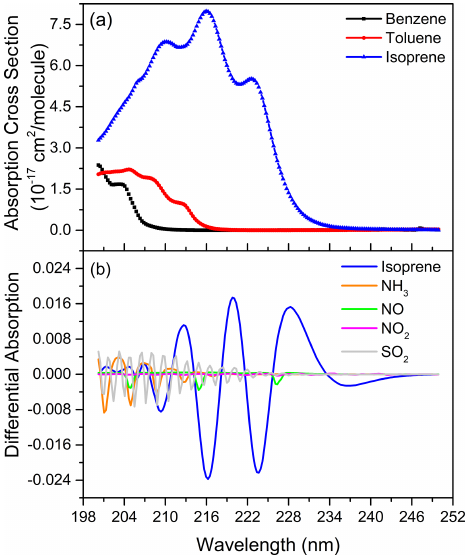
Figure 7. The absorption cross sections of benzene, toluene and isoprene (a) , the differential absorption spectra (1ppbkm) of NO, SO 2 , NO 2 , NH 3 and isoprene (b)